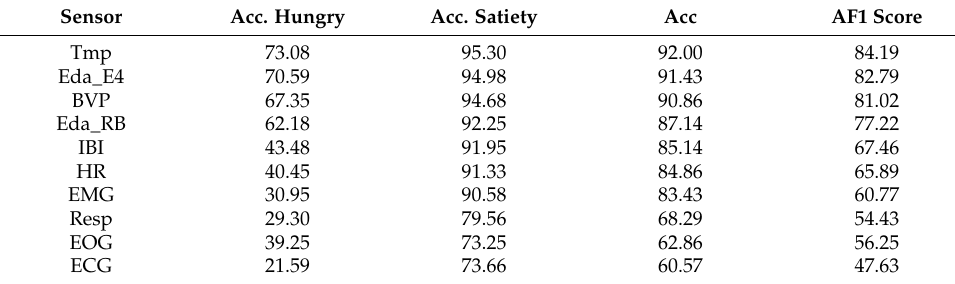
Table 6. Hunger and satiety classification results on each sensor channel using RF classifier. Sensor